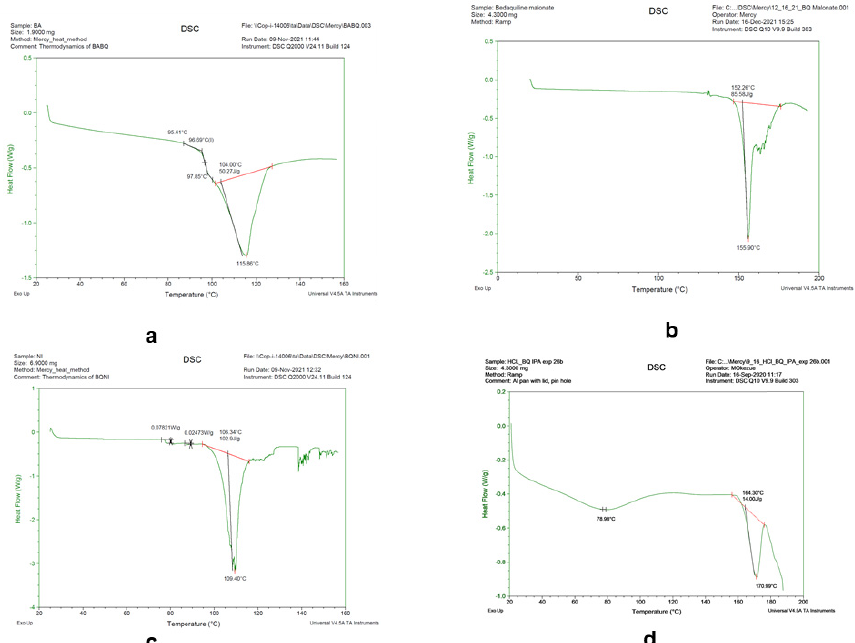
Figure 7. DSC endotherms for bedaquiline salts. ( a ) Endothermic maxima at 98 ◦ C and 104 ◦ C, corre- sponding to solvent evaporation and melting of benzoate salt prepared from acetonitrile; ( b ) malonate, showing melting point endotherm at ~152 ◦ C; ( c ) nicotinate, showing hydrate loss at 102 ◦ C, melt- ing point endotherm at ~130 ◦ C; ( d ) HCl, showing vapor loss at an initial dip, and melting point endotherm at ~164 ◦